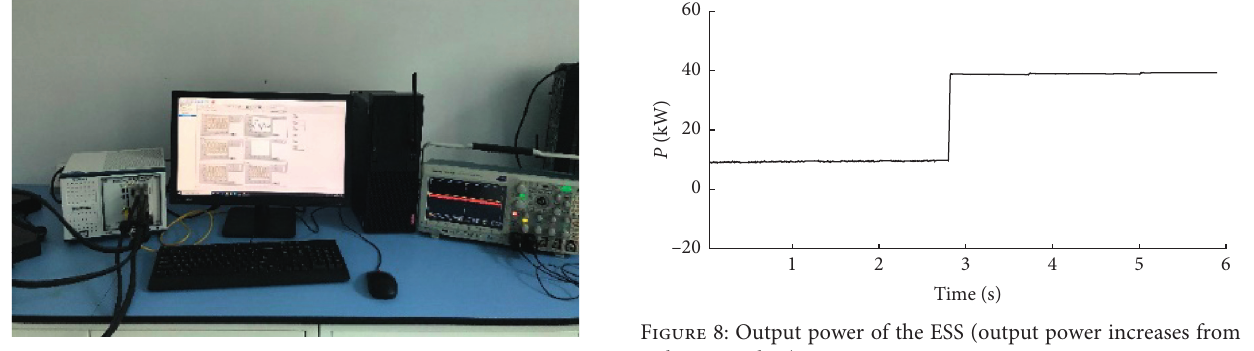
Figure 6: The NI-PXI platform.